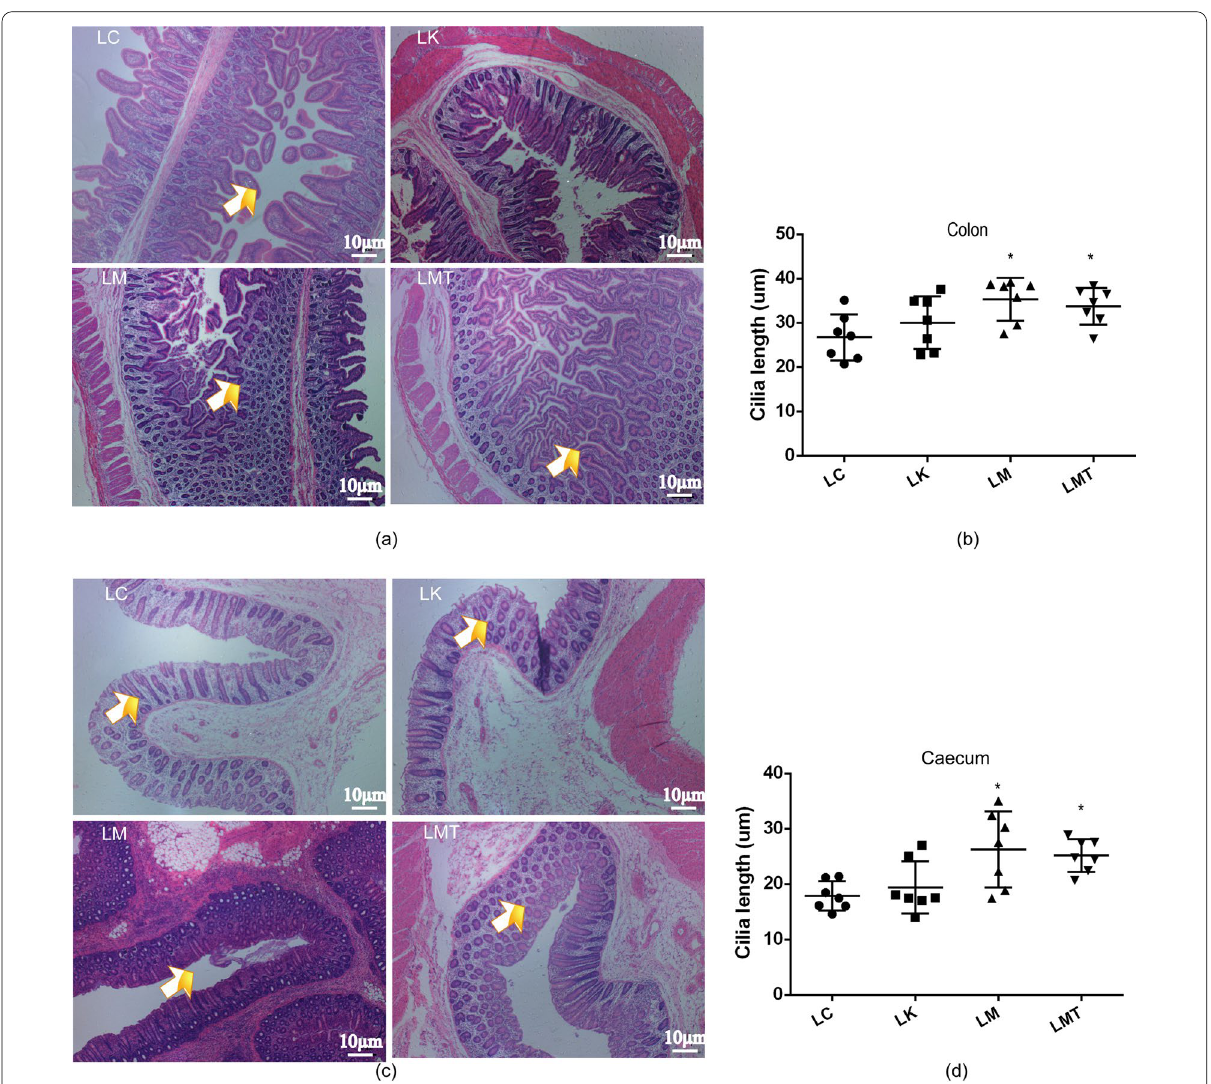
Fig. 4 Morphological changes in the cecal and colonic villi of weaned piglets. a Morphological changes in the cecum of the weaned piglets. b Length of colon villi. c Morphological changes in the cecal of weaned piglets. d Length of colonic villi in different groups ( * p < 0.05; ***p < 0.01